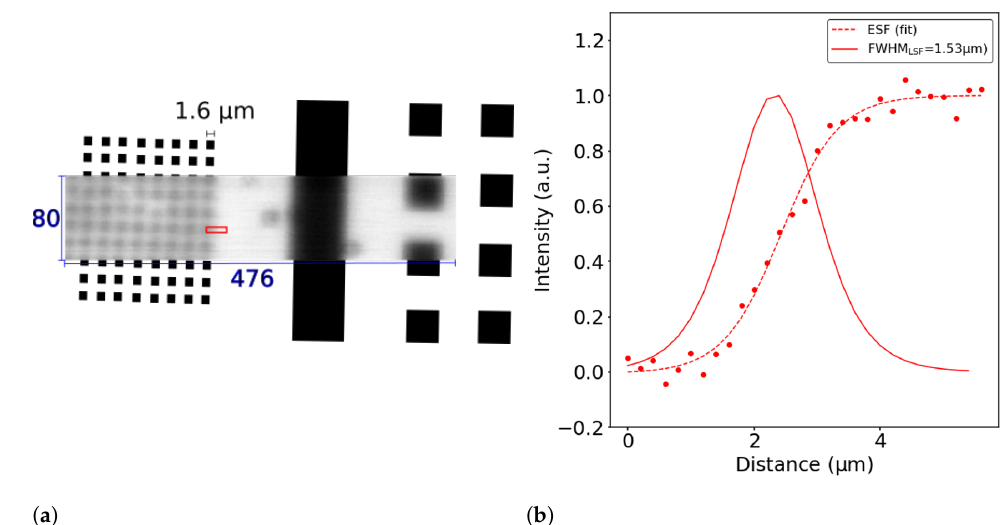
Figure 8. ( a ) Reconstructed image of 80 476 pixels with the region used for the extraction of the × ESF marked in red. The aluminum EBL pattern is schematically shown by black rectangles. ( b ) The ESF and LSF from the edge of a 1.6 µ m 1.6 µ m rectangle obtained with a scanning step size of × 200 nm. The ESF (dashed line) and LSF (solid line) were fitted to the measured data points (symbols) and normalized to unity.